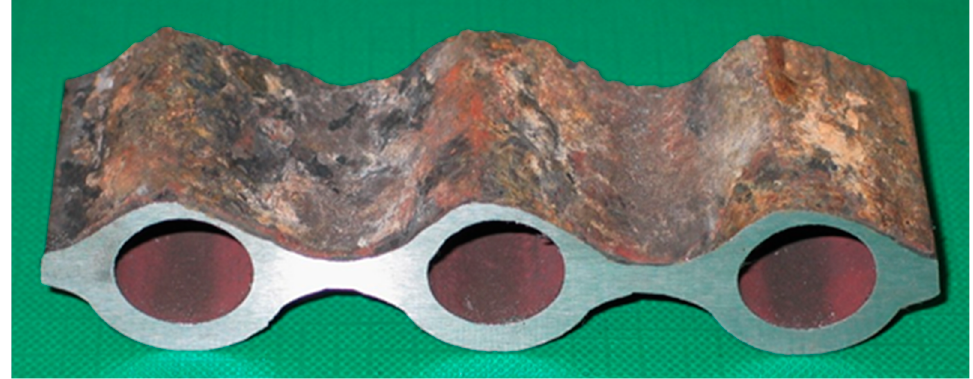
Figure 2. Cross section of a screen fragment that was damaged by coal and ash particles as a result of corrosion and fire degradation. corrosion and fire